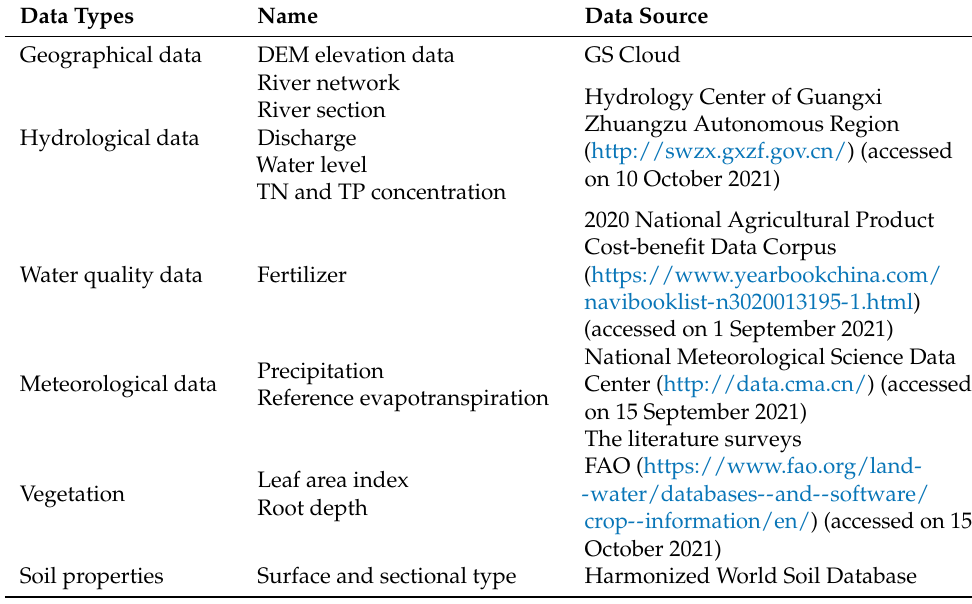
Table 1. The data required in the MIKE-SHE